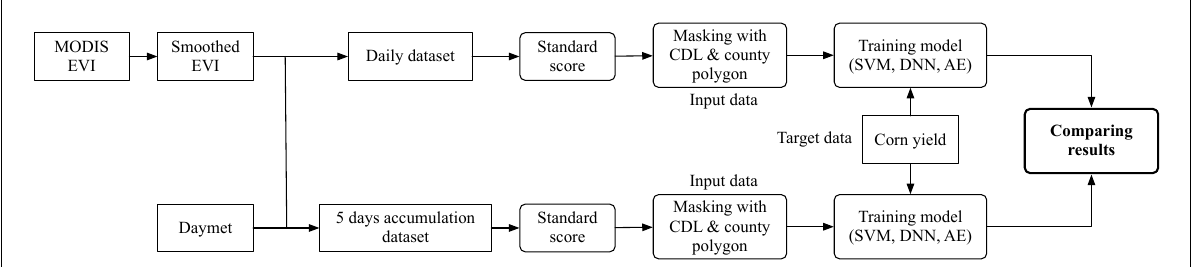
Figure 4: Flow diagram of methodology used in this study